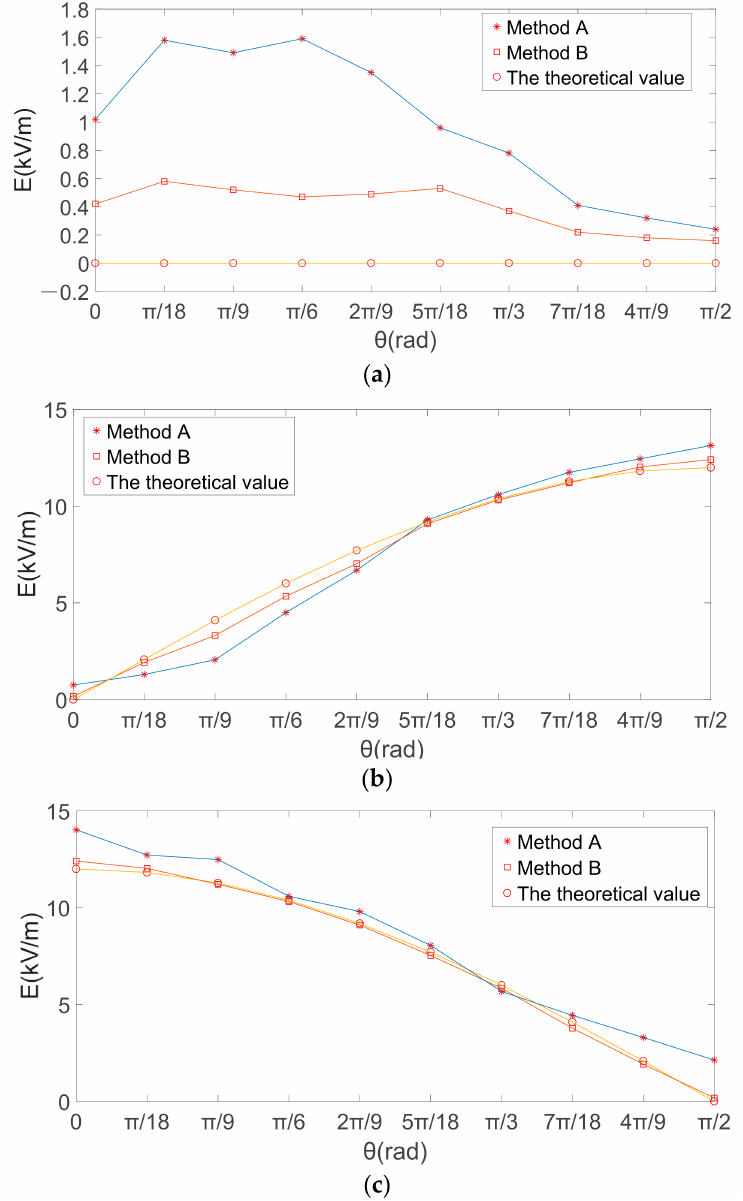
Figure 8. Electric-field intensity, E (kV/m). ( a ) X axis direction; ( b ) Y axis direction; ( c ) Z axis